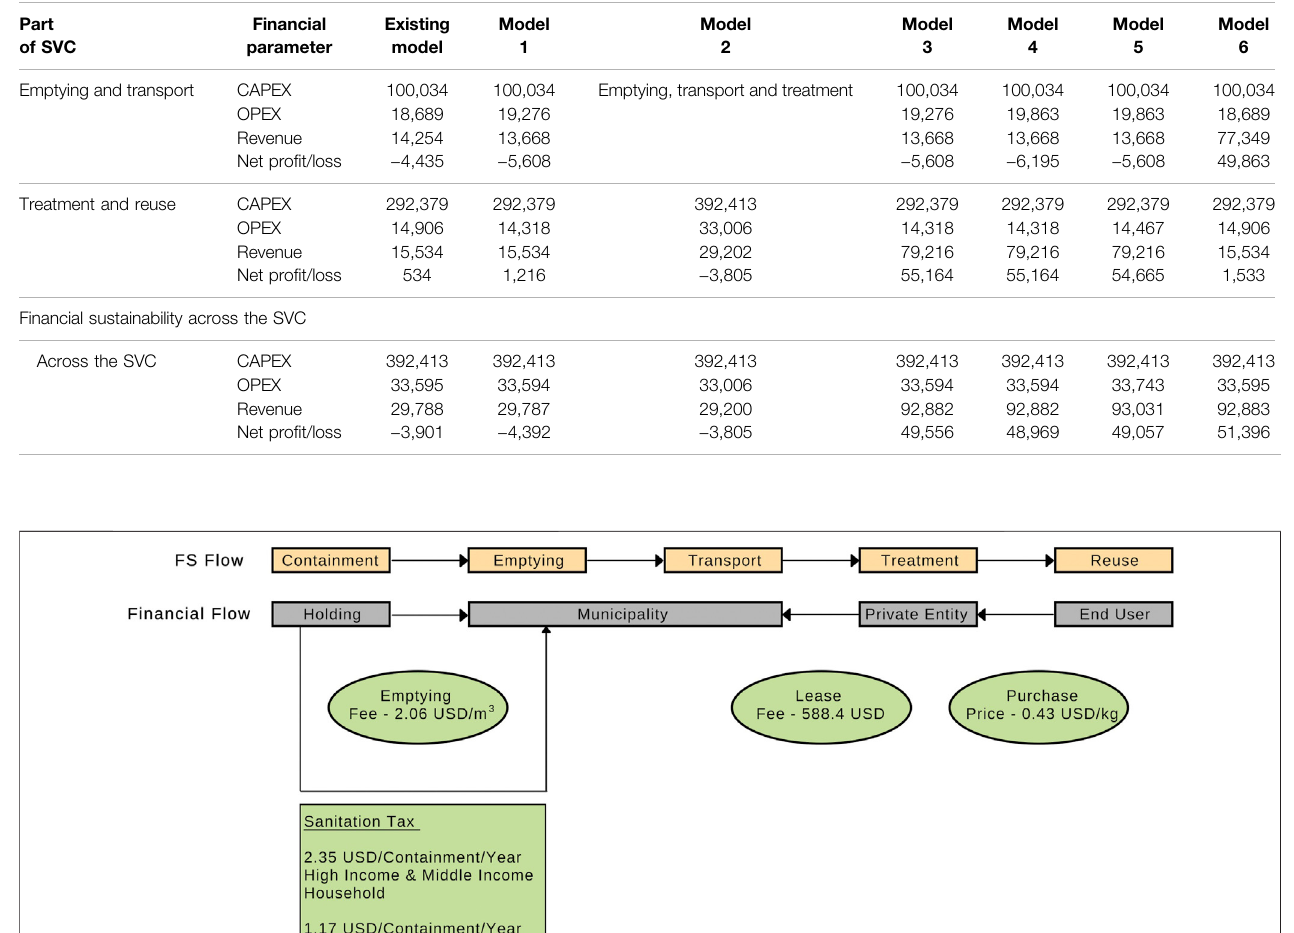
TABLE 7 | Analysis of fi nancial fl ow models (all fi gures in USD/year).